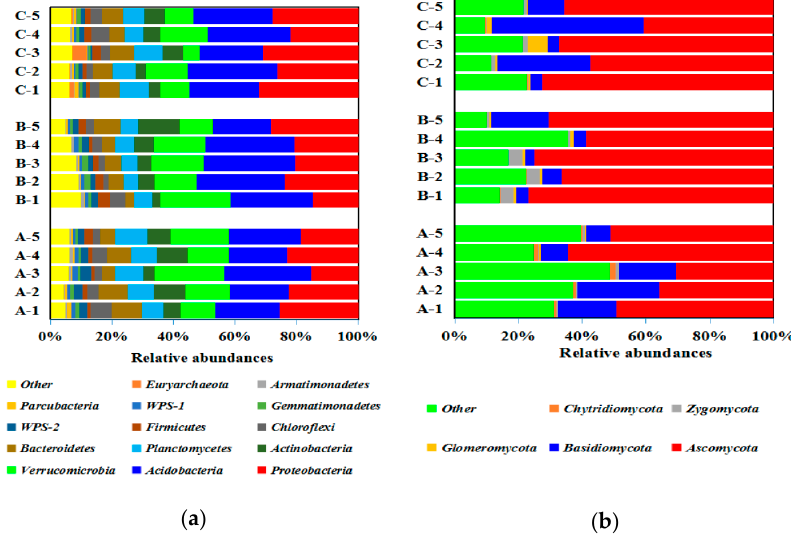
Figure 4. Relative abundance of ( a ) bacterial and ( b ) fungal phyla in different sites. “Other” includes phyla with less than 0.1% of relative abundance and unclassified phyla.